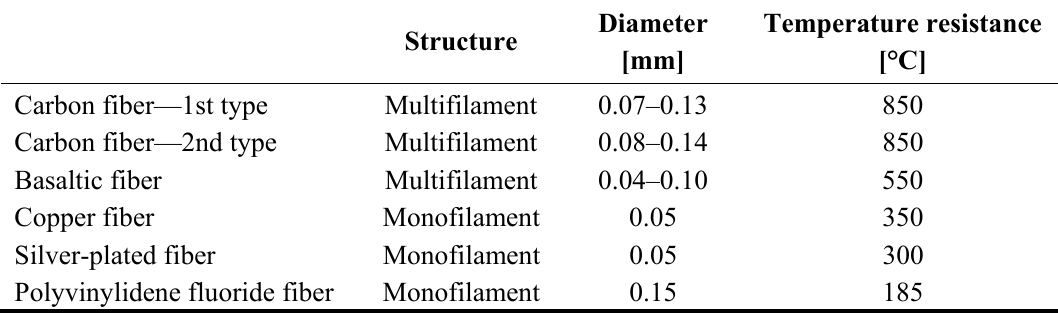
Table 1. Properties of examined fibers.